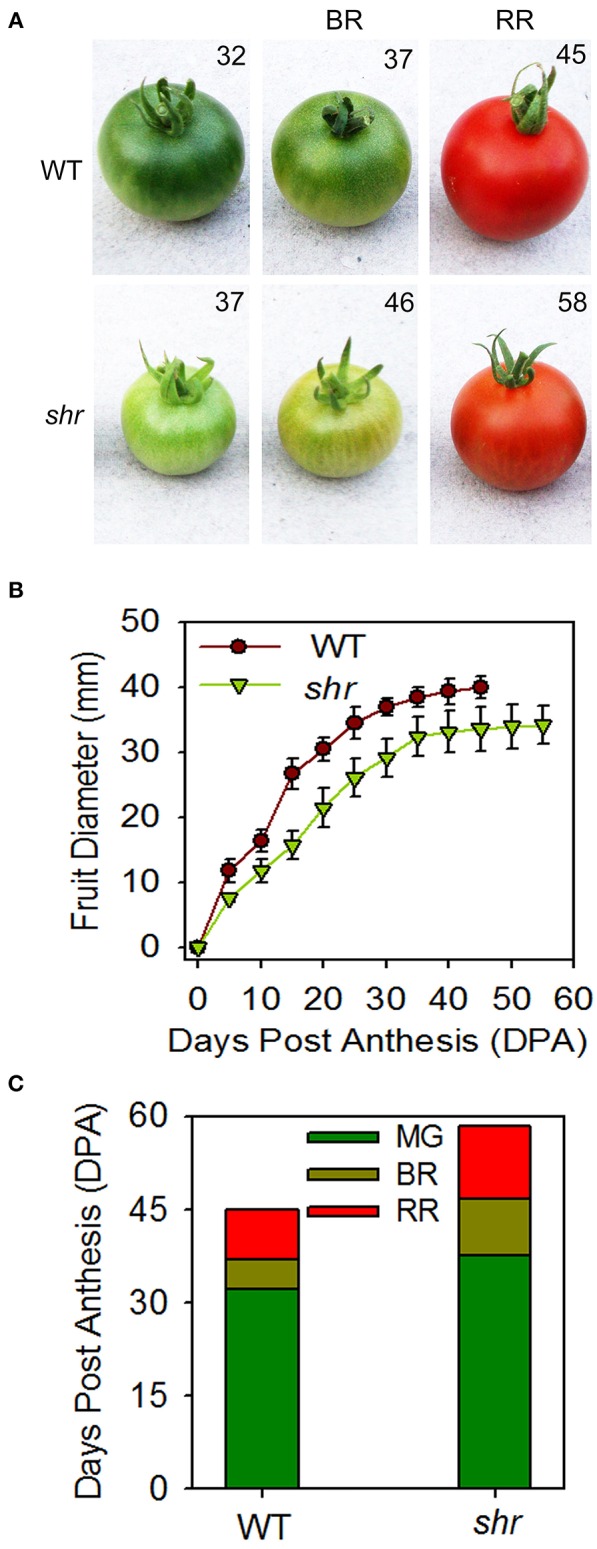
Fruit development and ripening of shr fruits. (A) WT and shr fruits harvested at different days from anthesis. (B) Time course of fruit development in WT and shr mutant from the day of anthesis to RR stage. (C) Duration of different ripening phases of WT and shr mutant fruits. The values are the mean ±SD (n = 5). All the data point statistically significantly different between WT and shr were determined throughOne-Way ANOVA (P < 0.001).